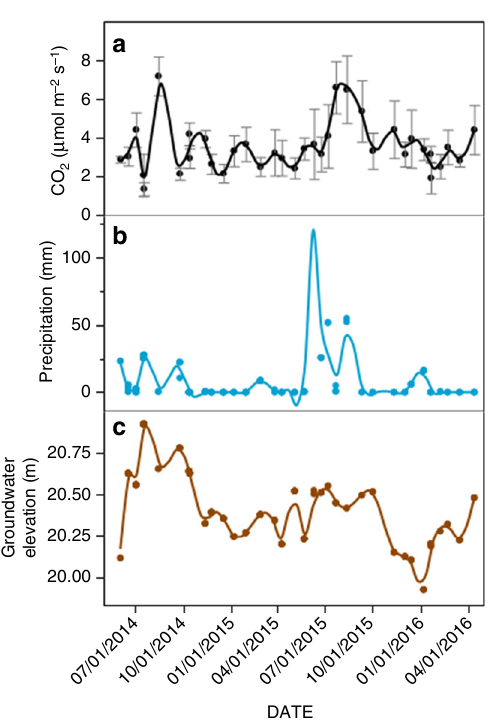
Fig. 5 Field-scale carbon dioxide fl ux, precipitation and groundwater rise. (bars represent standard error of n = 8 plots), and weather tower reports at Walker Ranch Weather Station at the Disney Wilderness Preserve (FL) of b total precipitation (mm) and c mean groundwater level (m) for 24 h prior to CO 2 measurements. Using a residual maximum likelihood mixed effects model, CO 2 emissions were in fl uenced by precipitation ( P = 0.040) and by the interaction of precipitation and groundwater elevation ( P =